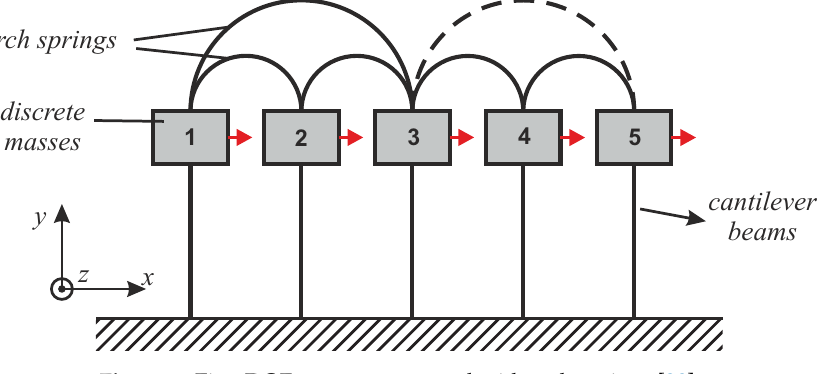
Figure 2. Five-DOF system connected with arch springs [28].